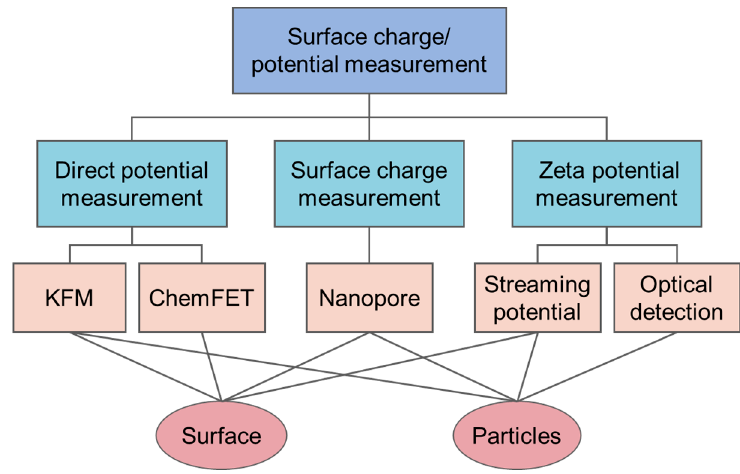
Figure 1. Surface charge/potential measurement techniques.